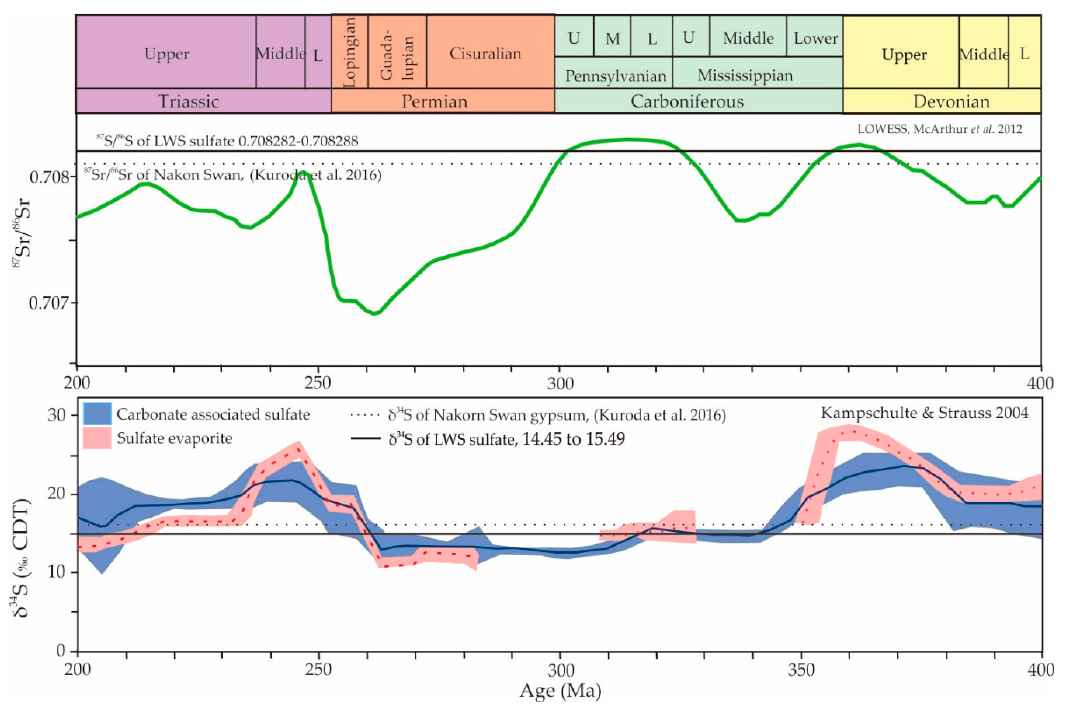
Figure 2. Secular variations of strontium ( 87 Sr/ 86 Sr, middle panel) and sulfate sulfur ( δ 34 S, bottom panel) isotopic compositions in ocean water from 400 to 200 Ma. The 87 Sr/ 86 Sr values (green curve) are from Locally Weighted Scatterplot Smoothing (LOWESS) (data compiled by McArthur et al. 2012 [22]), and the δ 34 S values of carbonate-associated sulfates (blue curve) and sulfate evaporites (red) were compiled by Kampschulte and Strauss (2004) [23]. Horizontal lines indicate the data for the LWS sulfate samples when compared with the Nakon Sawan gypsum samples analyzed by Kuroda et al. (2016) [21].